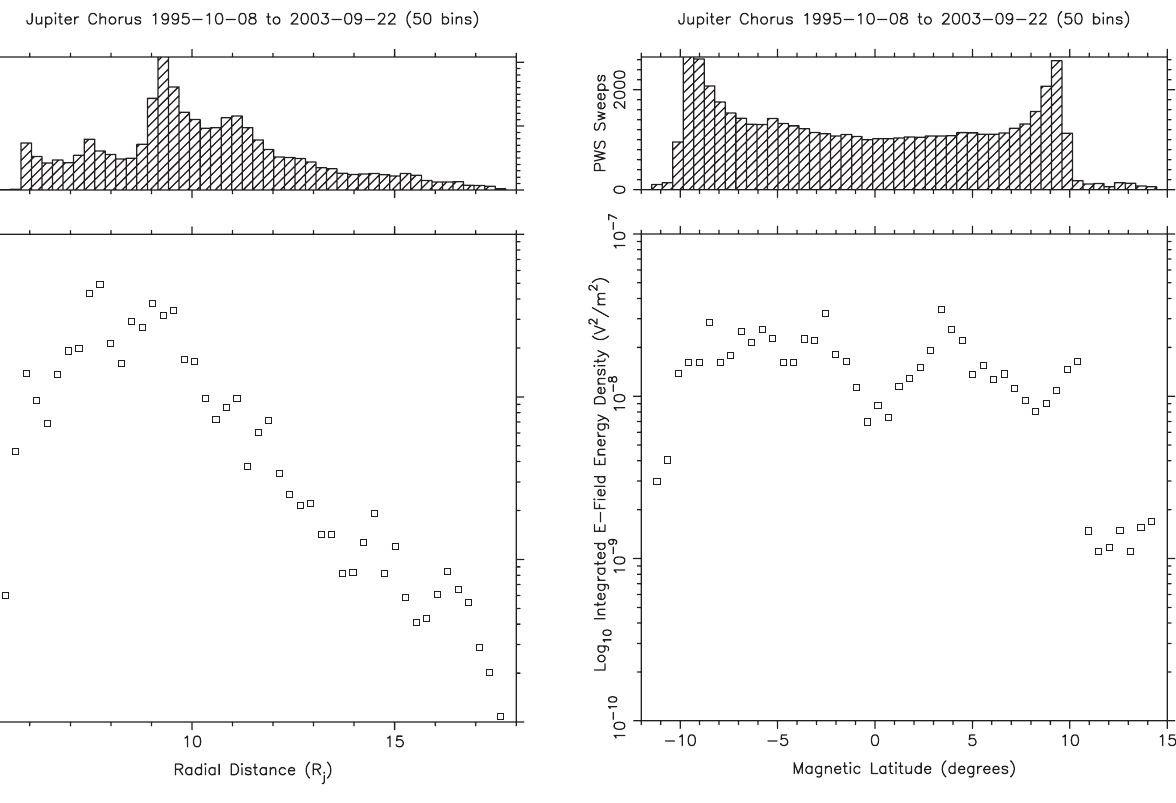
Fig. 5. Integrated chorus power as a function of radial distance (lower panel). In this and in the following figures the top panel shows the number of frequency sweeps within each bin. There are 50 bins for each range of parameter.